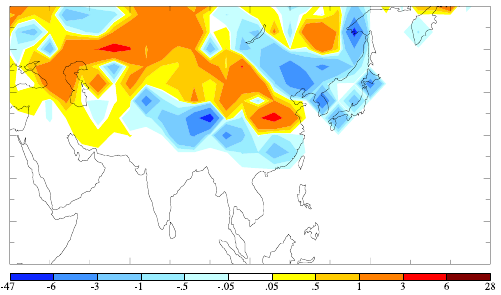
Fig. 4. Similar to Fig. 3 but for changes in annual average snow/ice cover for a simulation with (D+I) effects but without any anthro- pogenic black carbon for Year 1990 and 2000